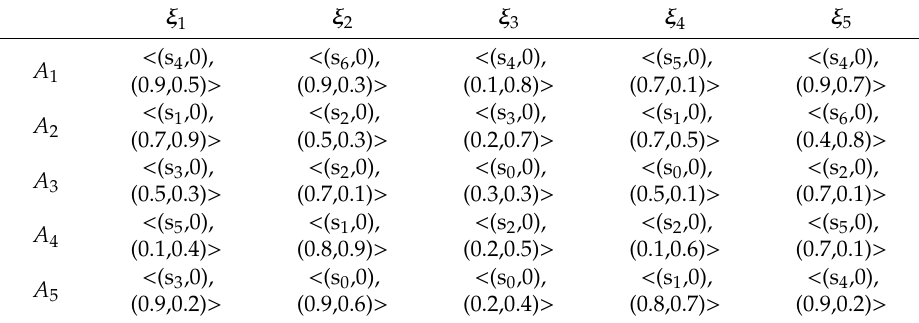
Table 3. P2TLN decision matrix by DM 3 .